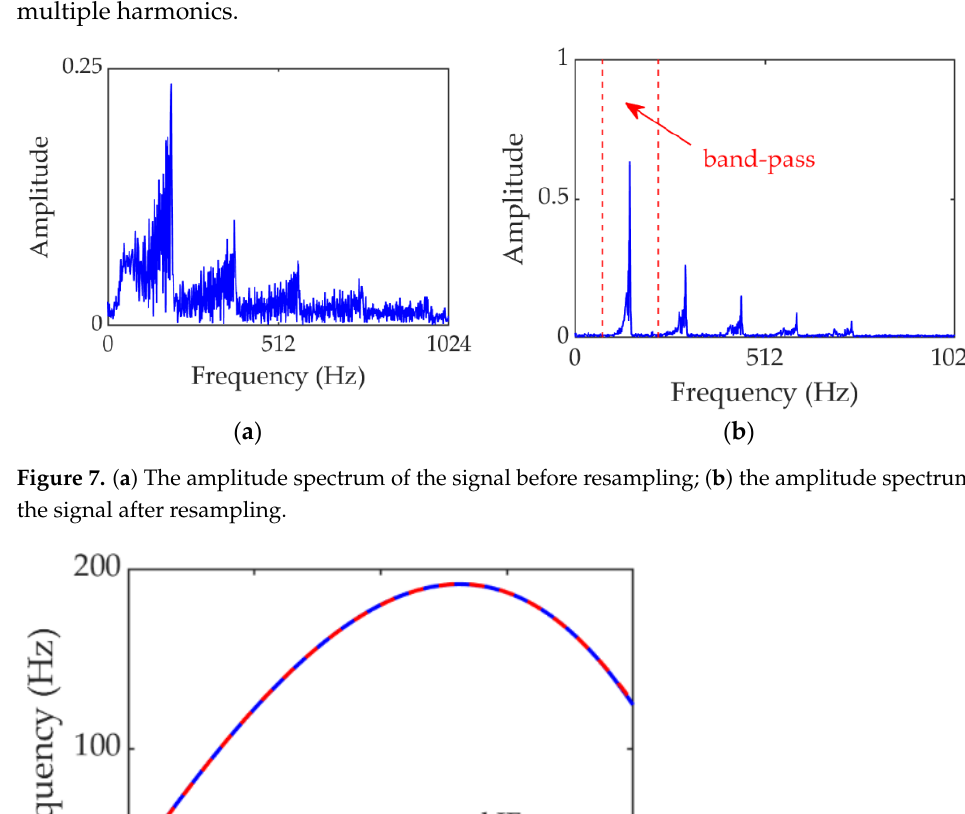
( b ) Figure 6. ( a ) The IF estimated by PIFEM for the signal without noise; ( b ) the IF estimated by PIFEM for the signal with noise (SNR = 10 dB). Then, by resampling the signal in the angular domain according to the estimated IF,